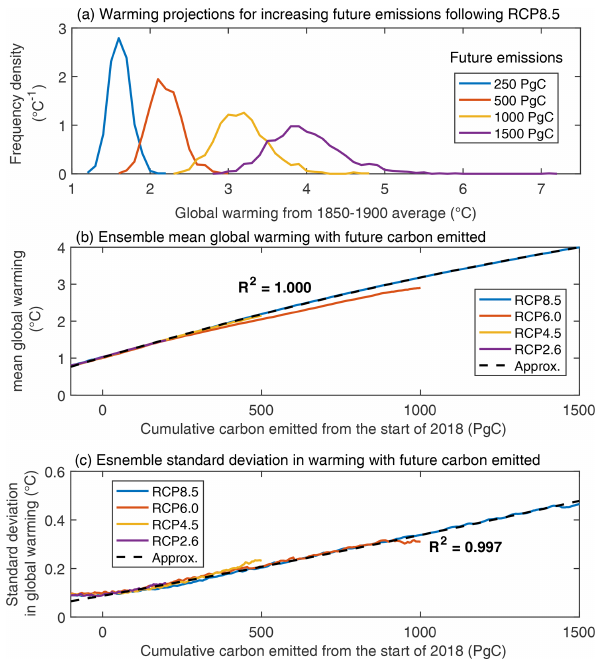
Figure 3. Projections of global mean surface warming from the history-matched WASP ensemble for different future carbon emis- sion sizes. (a) Frequency distributions of projected warming in the WASP ensemble for different future carbon emission sizes after the start of 2018. (b) Ensemble-mean global warming as future cumu- lative carbon emitted increases. (c) Ensemble standard deviation in global warming as future carbon emitted increases. Panels (b) and (c) show the RCP8.5 (blue), RCP6.0 (red), RCP4.5 (orange) and RCP2.6 (purple) scenarios. A quadratic approximation, Eq. (3) for (b) and Eq. (4) for (c) , is a good fit to the RCP8.5 scenario (thin black line). All panels show warming calculated relative to the 1850–1900